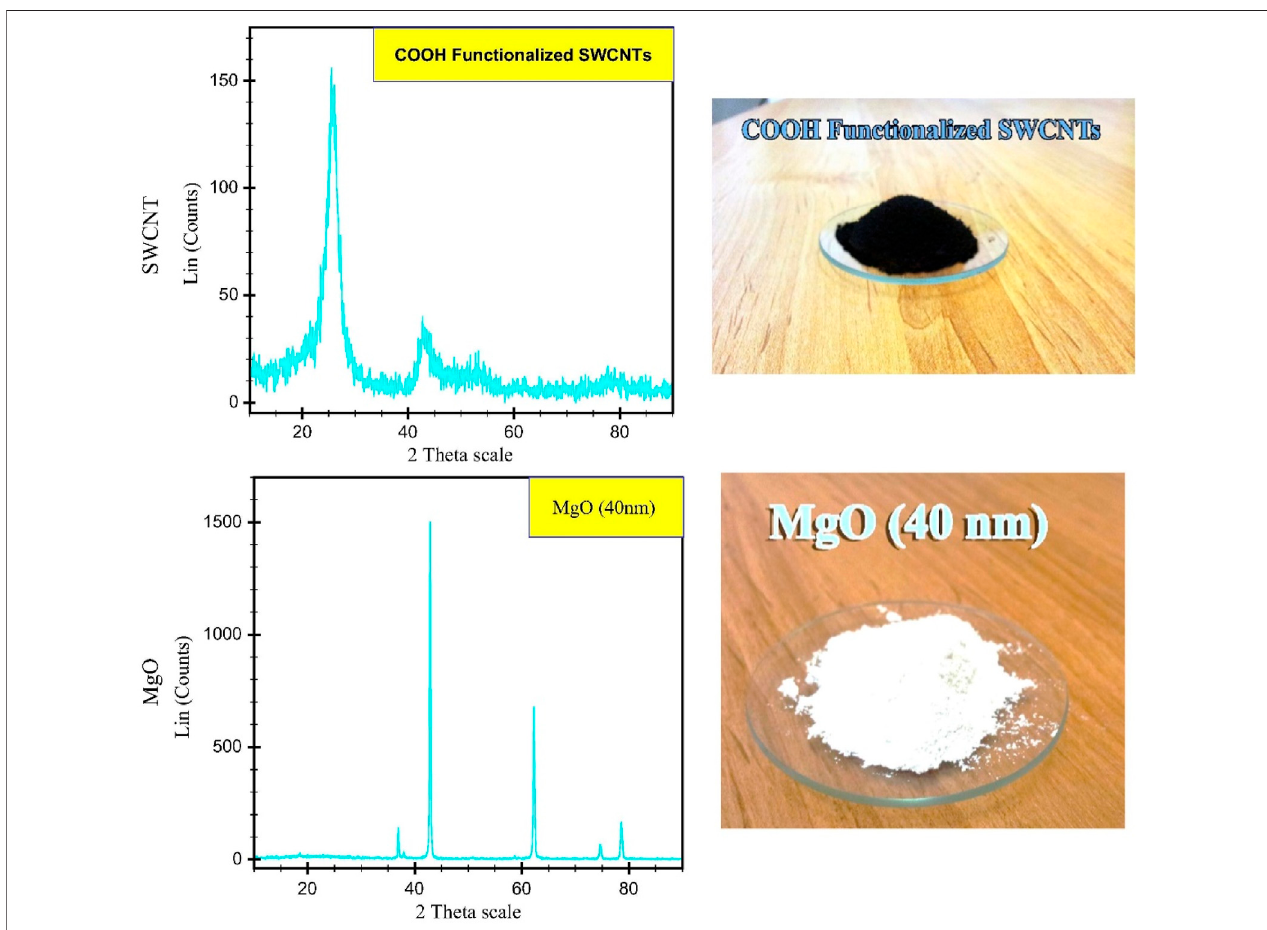
FIGURE 3 | XRD analysis of prepared nano powders (Hemmat Esfe et al., 2017).